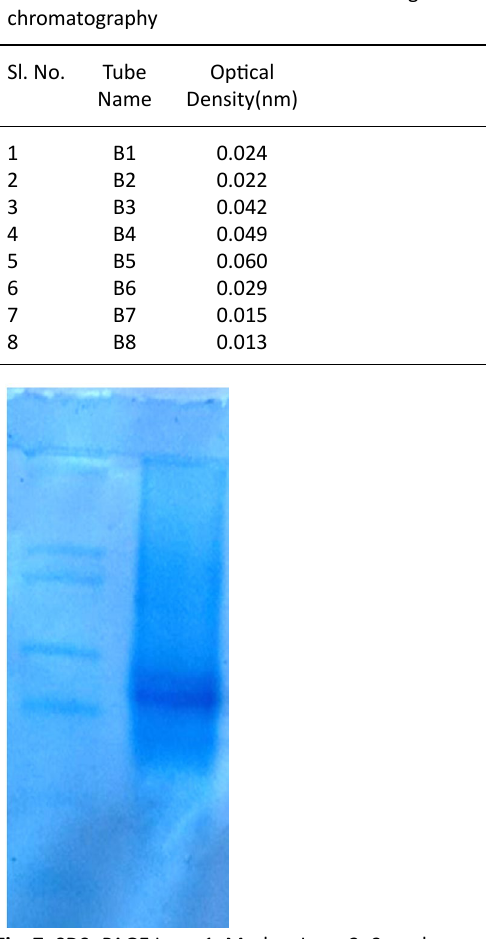
Fig. 7. SDS- PAGE Lane 1. Marker, Lane 2. Sample